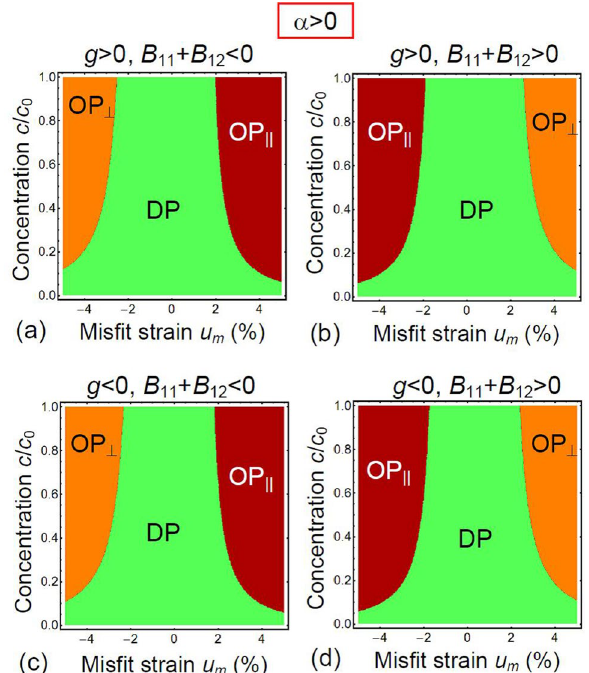
Figure 4. Phase diagrams in dependence on normalized defect concentration c / c 0 and misfit strain u m calculated for different signs of gradient coefficient g and striction coefficients B ij (indicated above the plots), and α > 0 . Other parameters are the same as in Fig.